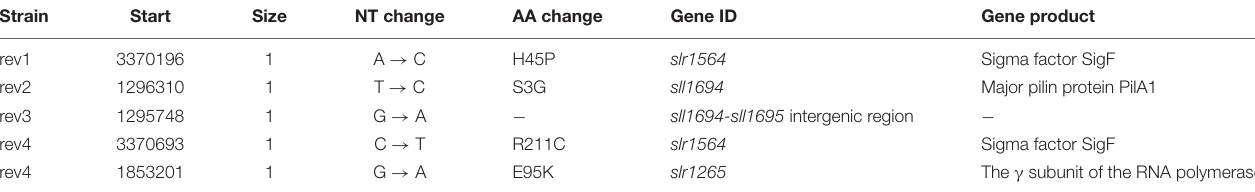
TABLE 1 | List of mutations identified by sequencing of (cid:49) pilD revertants. Strain